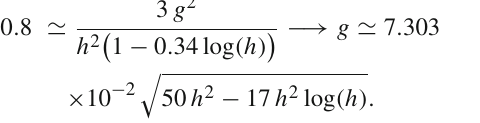
with C r = 70 (purple) and C r = 150 (orange). We compare theoretical predictions of ( r , n s ) for different values of N ranging from [ 40 , 100 ] and keep C 1 fixed with C 1 = 8 . 0 × 10 − 1 with Planck’18 results for TT, TE, EE,